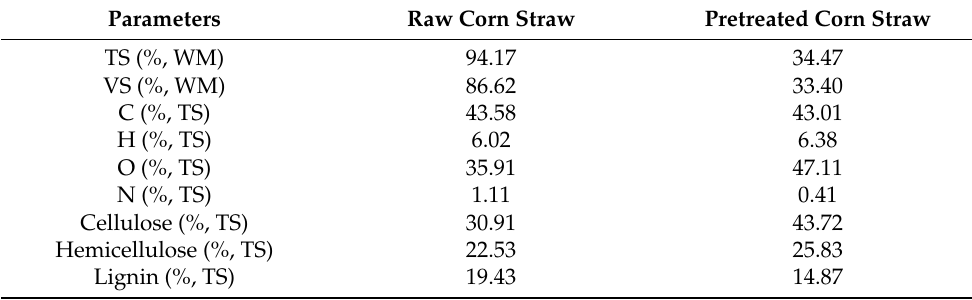
Table 1. Characteristics of corn straw used for anaerobic